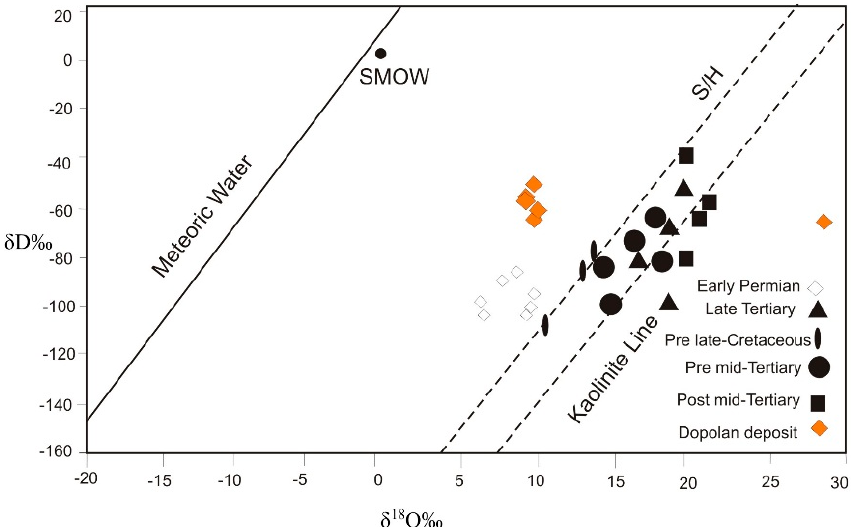
Figure 17. Relationship between δ 18 O and δ D values for clay minerals from Australian regolith profiles (Data from [78] and the Dopolan kaolinite. SMOW, Standard mean ocean water; S/H = supergen/hypogene kaolinite line from [61]; Kaolinite line from [59].